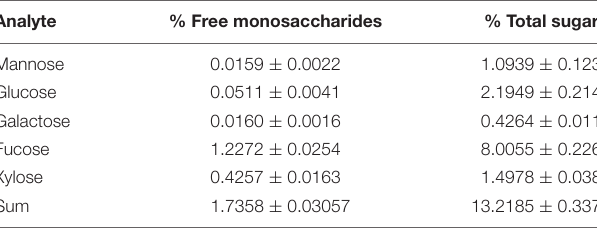
TABLE 2 | Free monosaccharide and total monosaccharides quantified in ANE. Analyte